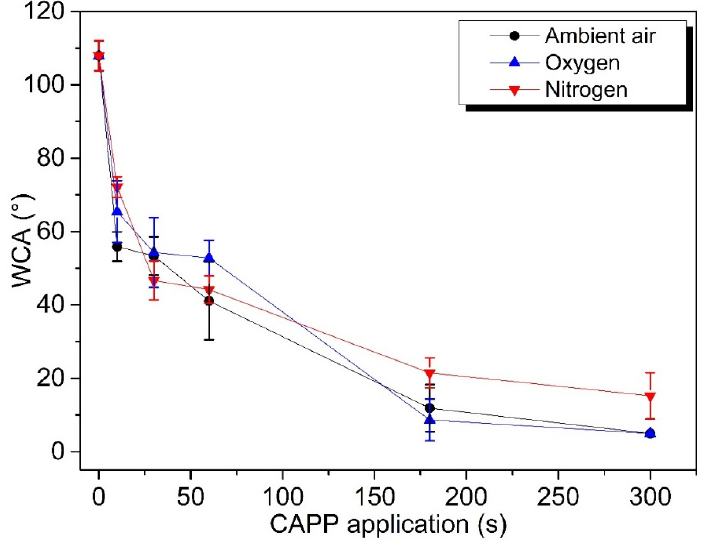
Figure 2. Effect of plasma exposure time on the water contact angle (WCA) measured on maize grains, samples treated by ambient air, oxygen, and nitrogen Diffuse Coplanar Surface Barrier Discharge (DCSBD) plasma at atmospheric pressure, the input power was 400 W. Values are the mean ± SD, n = 10.